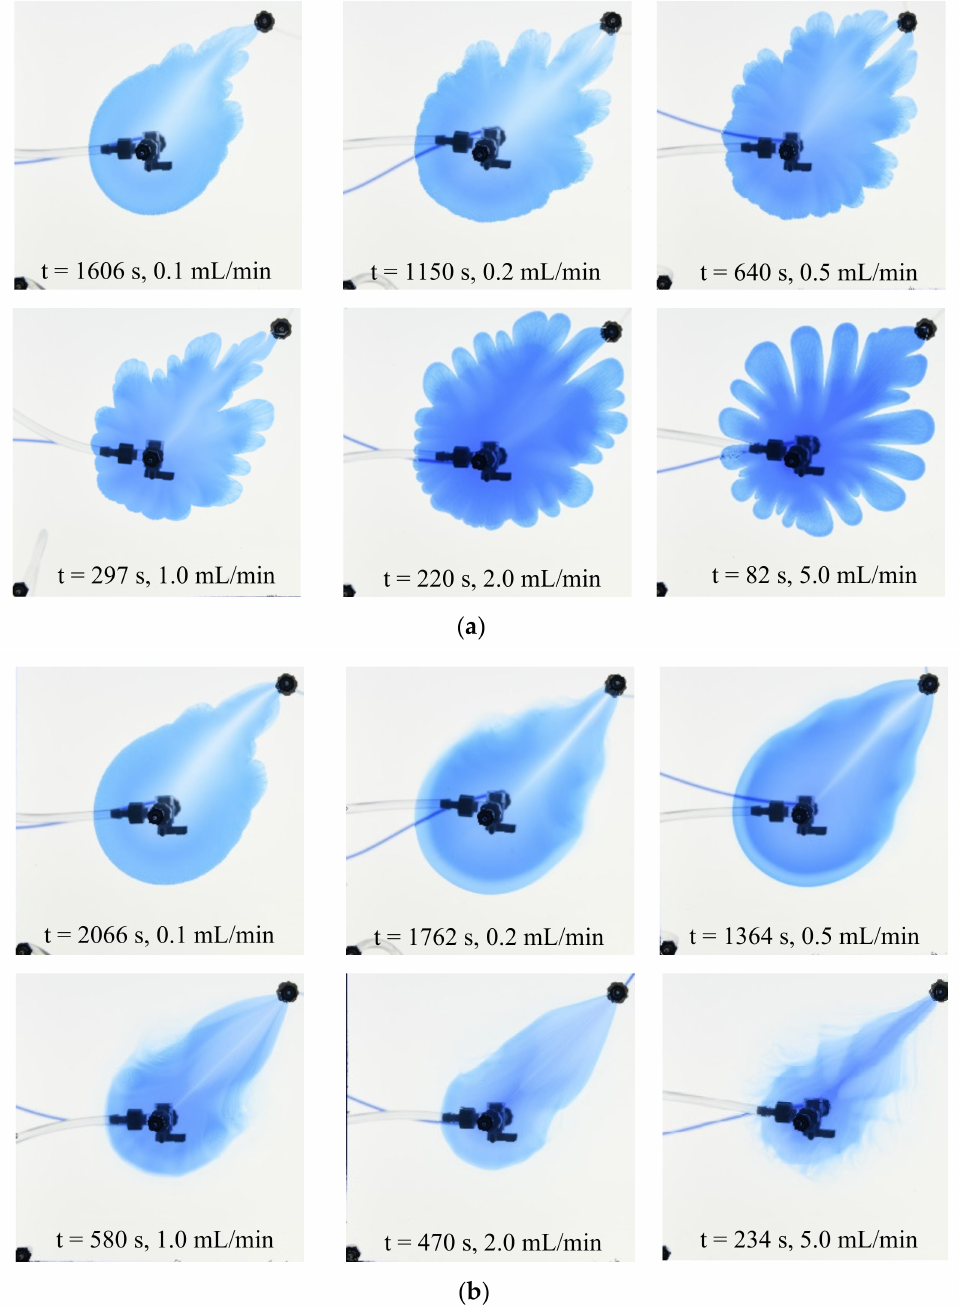
Figure 7. Viscous fingering for different injection rates under constant pressure control at the outlet. ( a ) at breakthrough time; ( b ) at the end of fast shrinkage